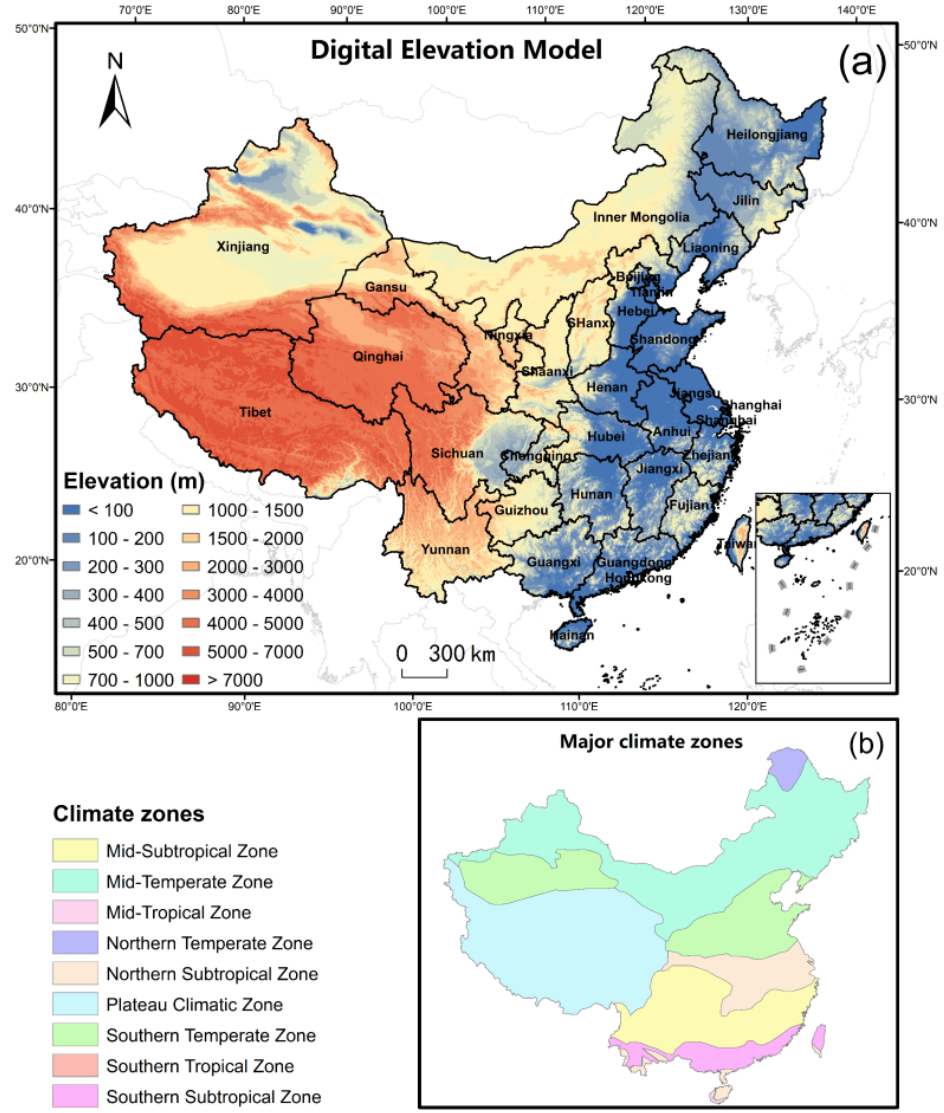
Figure 1. Digital elevation model and climate zones of China with annotation of the provinces.